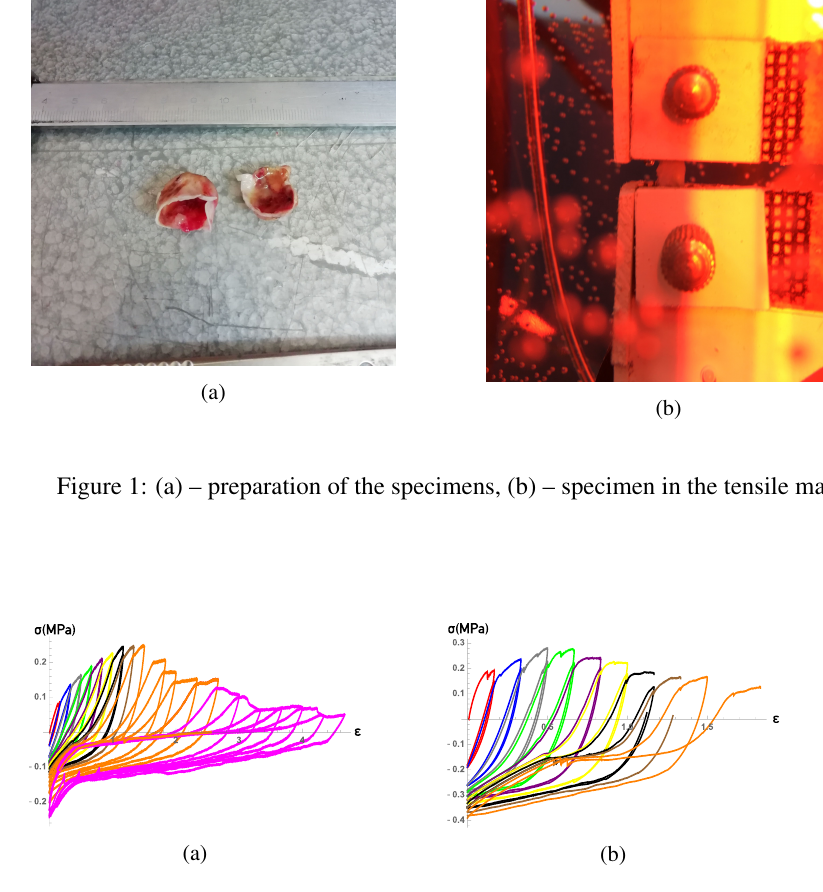
of these zones. Around large foci, the presence of di ff use microcrystalline calcification is noted. The structure of the layers in the vessel wall is erased, the smooth muscle fibers of the middle layer are dystrophic altered, in several places they have completely lost their typical structure. There is total interfiber swelling of the vessel wall (Fig.